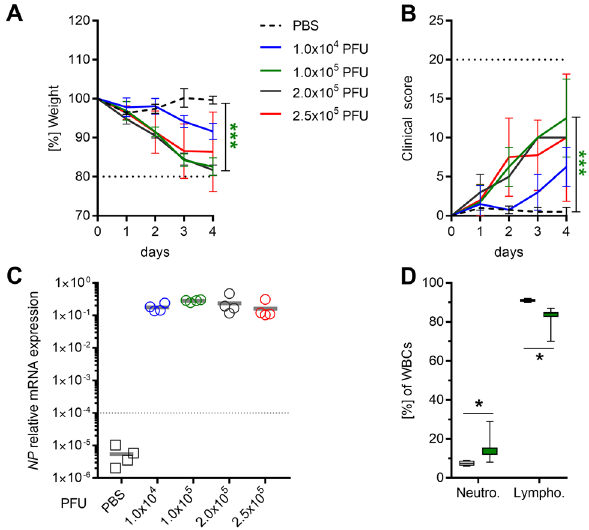
Figure 2. C57BL/6J mice are susceptible to non-mouse adapted H1N1 IAV. C57BL/6J were intranasally inoculated with indicated PFUs of H1N1 or challenged with PBS and monitored over 4 consecutive days. ( A ) Weight and ( B ) clinical score were determined daily. Horizontal dotted lines in A and B indicate termination conditions (20% weight loss and/or clinical score of 20) of the experiment. ( C ) On day 4, lungs were extracted and viral infection was confirmed via IAV NP -specific qRT-PCR (dashed line indicates detection limit). ( D ) WBC limited to neutrophil and lymphocyte counts were determined at day 4. One experiment with four mice per group (total: n = 4) was performed ( A – D ). In general, mean values ± SD are displayed ( A , B ). Each dot represents one mouse and horizontal lines display mean values ( C ). The data in ( D ) are displayed as box plots. The level of significance between the PBS and all other groups in ( A ) was determined using Kruskal Wallis test with Dunn’s multiple comparison post-test. In ( D ), Mann Whitney U -test was performed (* p <